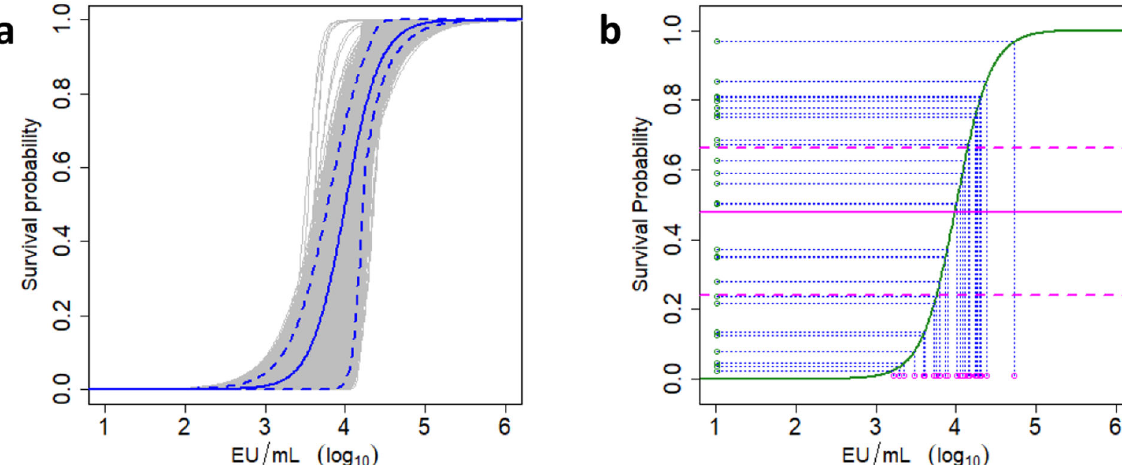
Fig. 5 Immunobridging of human EBOV GP-binding antibodies to the NHP-challenge model. a Visual representation of bootstrap method to derive 95% con fi dence interval. Logistic model is shown in blue. Gray lines represent 10,000 bootstraps of NHP dataset, to derive the 95% con fi dence bands (blue dashed lines) as the 250th and 9750th values of the ranked bootstraps above each ELISA value. The human EBOV GP-binding antibody data are bootstrapped 10,000 times on each of the NHP iterations to derive a 95% CI for survival probability. b Immunobridging of human GP-binding antibody levels from two phase I studies 23,25 using the logistic model based on GP-binding antibody levels and survival in NHP ( a ). Green line is logistic regression model based on Ad26.ZEBOV, MVA-BN-Filo regimen with an 8-week interval. Individual human GP-binding antibody levels and the associated survival probability based on the logistic model in NHP are indicated by blue lines. The point estimate for mean predicted survival probability (magenta solid line) is the average of the individual survival probabilities. The human EBOV GP-binding antibody data (magenta open circles, x -axis) are bootstrapped 10,000 times on each of the NHP iterations ( b ) to derive a 95% con fi dence interval (CI) for mean predicted survival probability (magenta dashed lines). Survival probabilities for the main logistic model (green closed circles, y -axis) are shown. EU ELISA